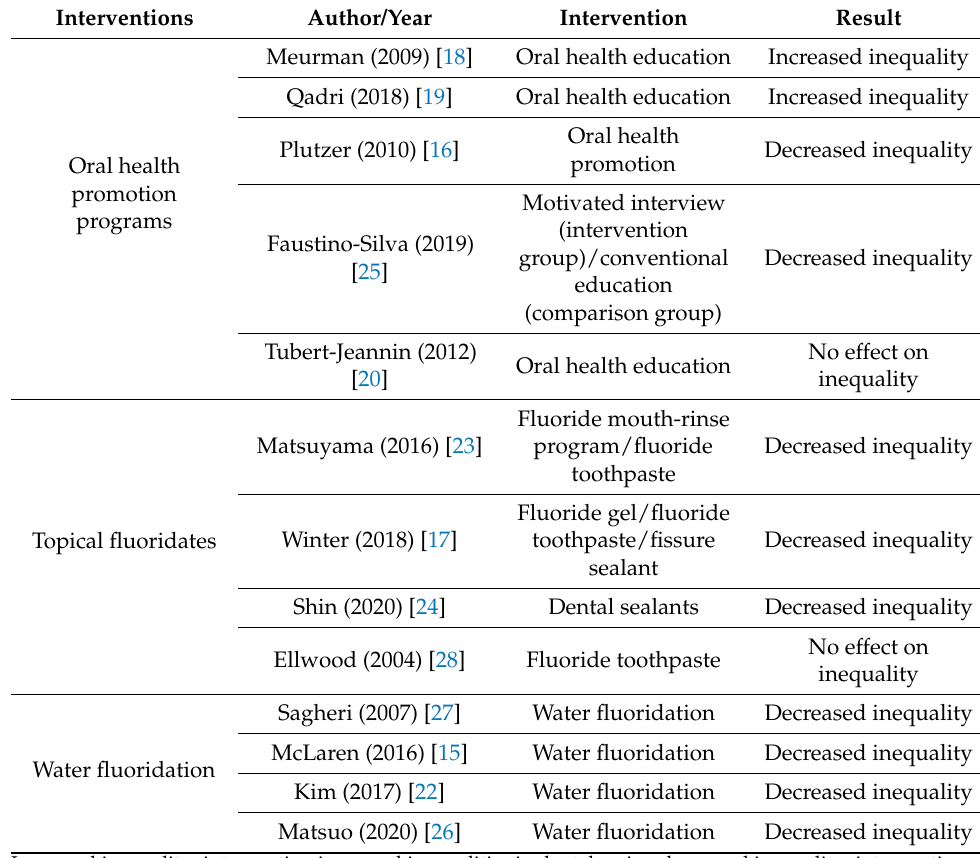
Table 1. The effect of different interventions on inequality in dental